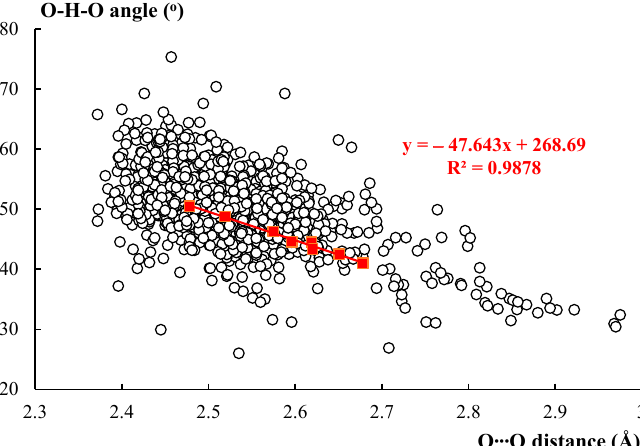
Figure 2. The relationship between the O ∙∙∙ O distance (Å) and the O–H ∙∙∙ O angle ( o ): the white circles correspond to experimental values taken from the Cambridge Structural Database (CSD); red squares correspond to the theoretical results concerning the malonaldehyde and its fluorine derivatives.